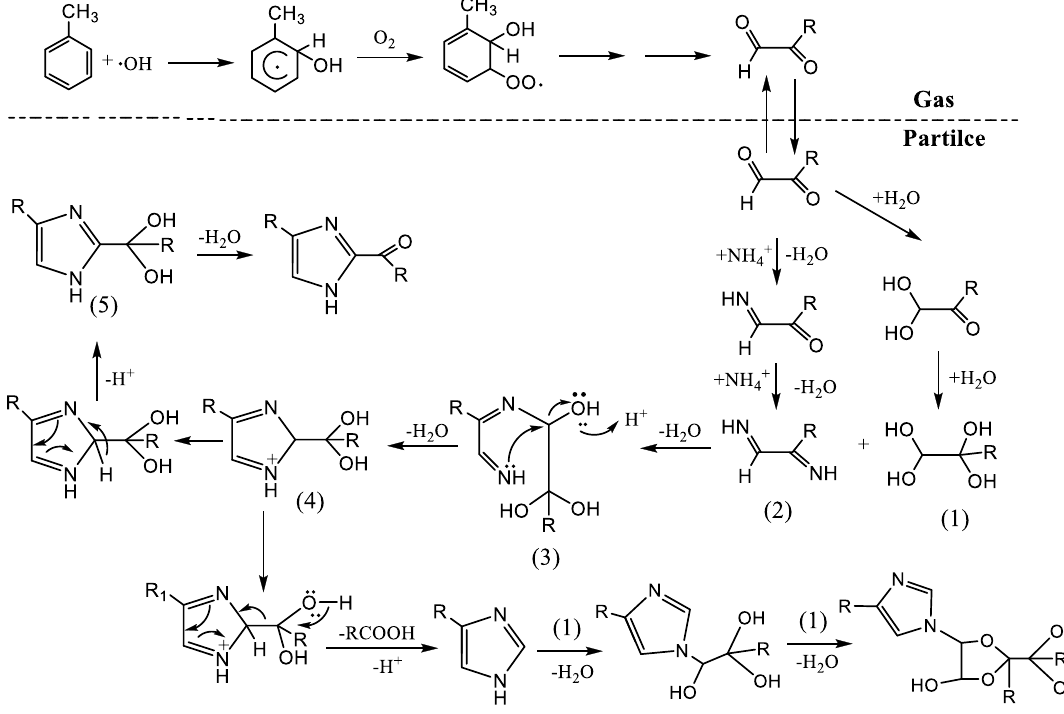
Figure 10. Suggest mechanism for imidazole compounds.